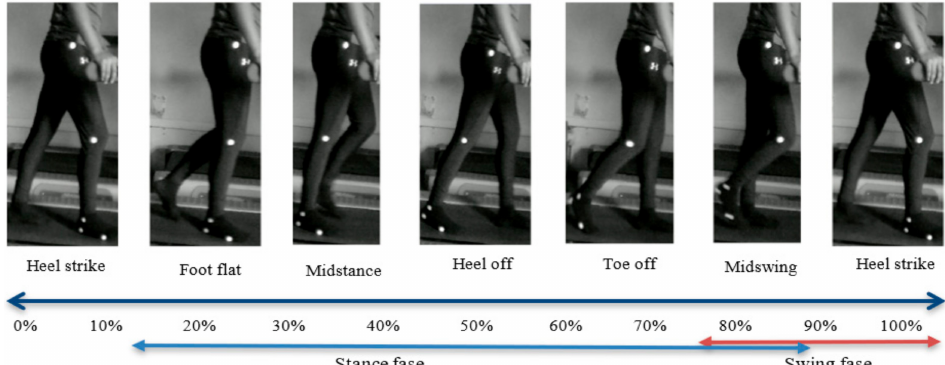
Figure 2. Full gait cycle for the test